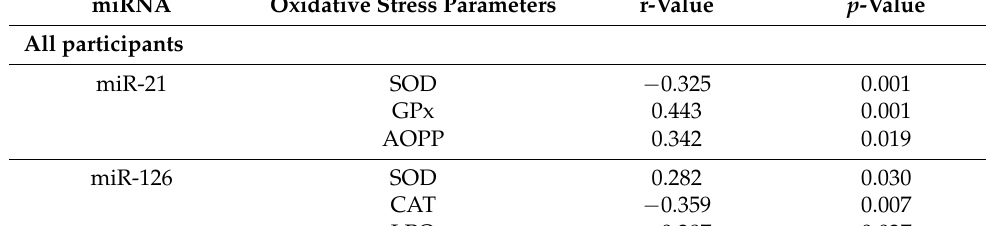
Table 4. Summary of significant ( p < 0.05) Pearson correlations (r) between plasma miRNA levels and oxidative stress and inflammatory measurements in all participants. miRNA Oxidative Stress Parameters r-Value p